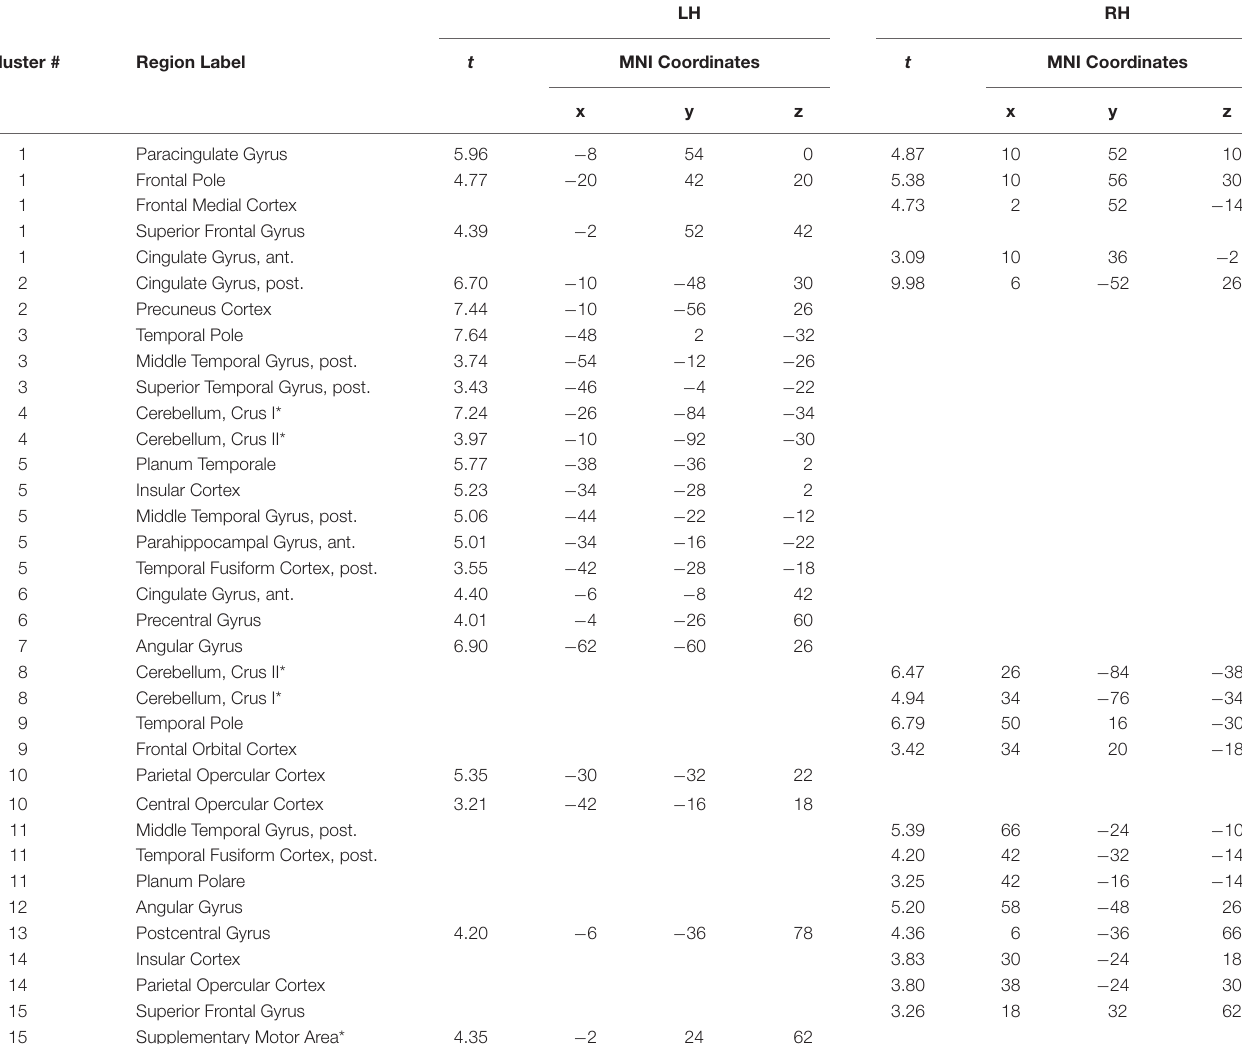
TABLE 2 | Regions of greater activation in group compared to individual problem solving: Peak coordinates and anatomic labels. LH